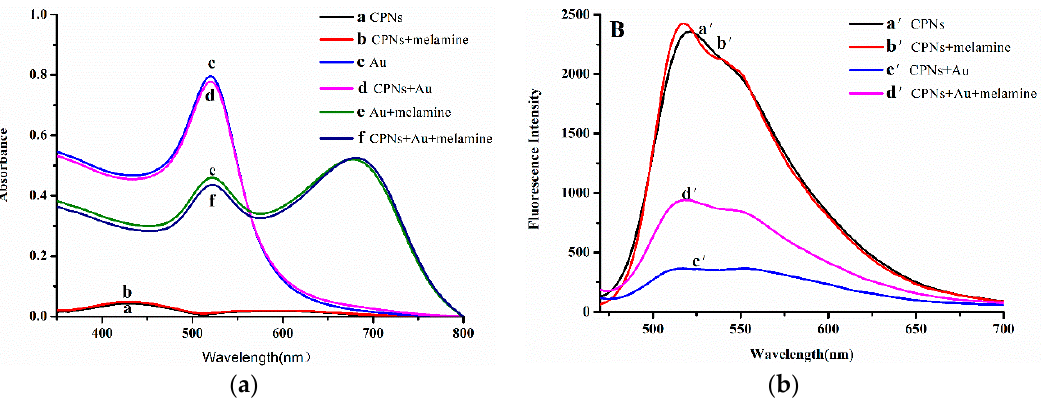
Figure 5. ( a ) Absorption spectra; a: CPNs; b: CPNs and melamine; c: AuNPs; d: AuNPs and CPNs; e: AuNPs and melamine; f: mixture of CPNs, AuNPs and melamine; ( b ) fluorescence spectra; a’: CPNs; b’: CPNs and melamine; c’: AuNPs and CPNs; d’: mixture of CPNs, AuNPs and melamine; CPNs: 0.187 μ M; AuNPs: 2.37 nM; melamine: 0.8 μ M.